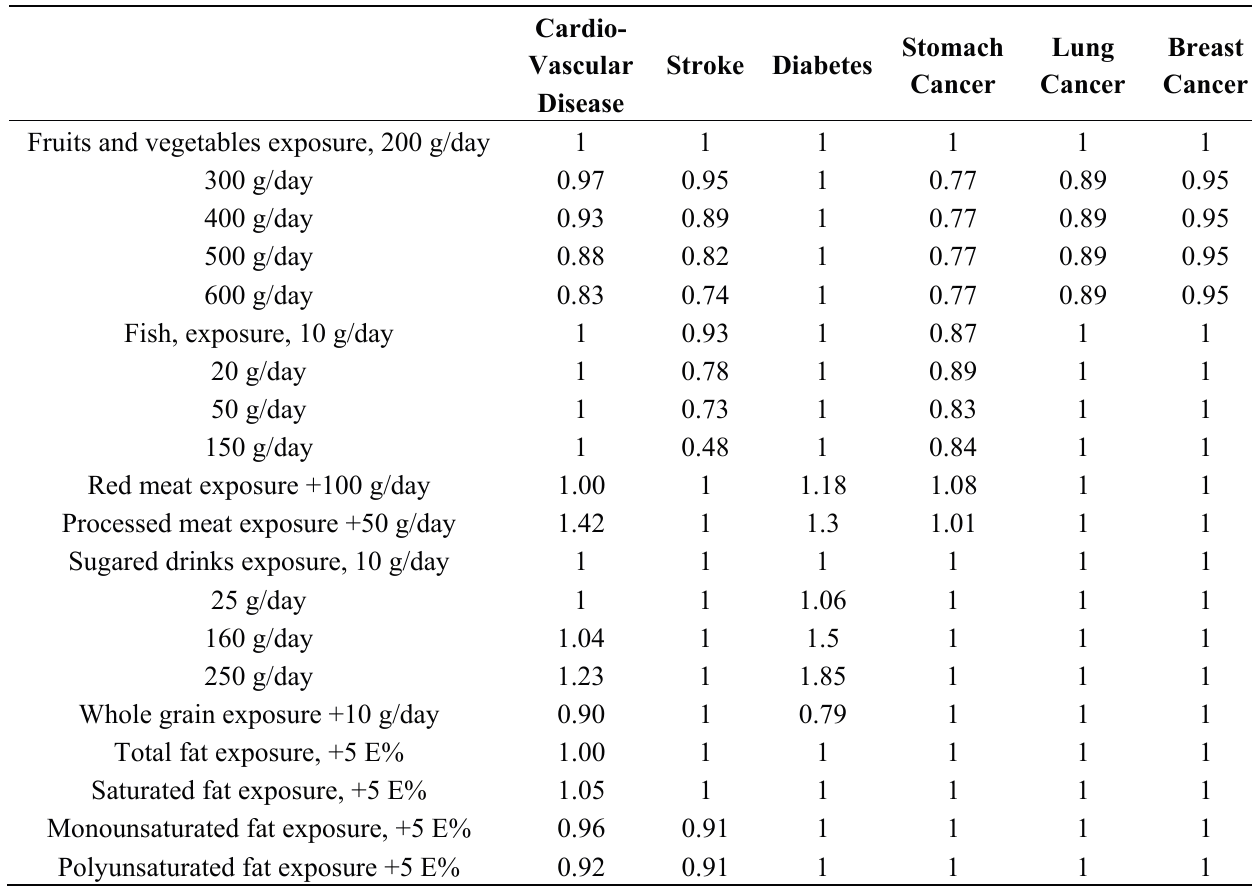
Table S3. Relative diet-related health risks.